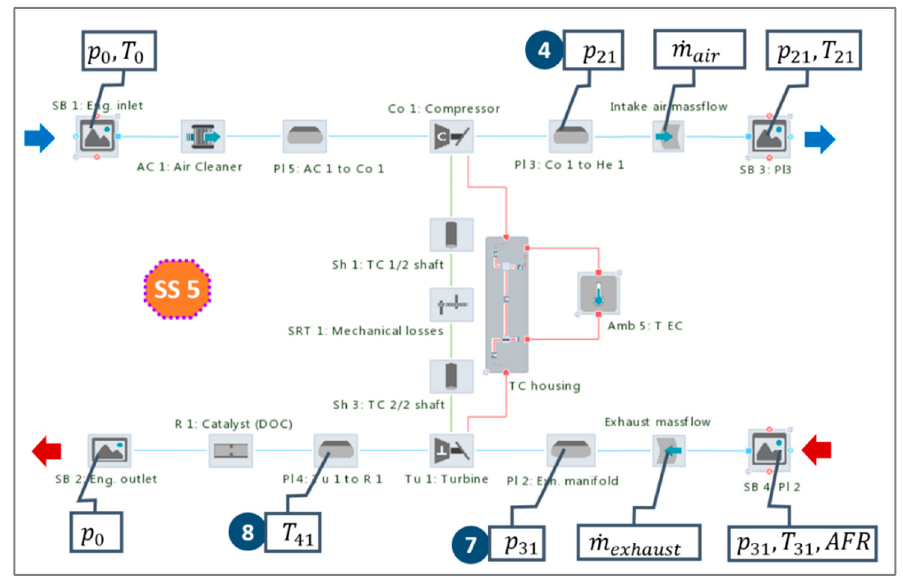
Figure 7. Layout of the simulation model of the turbocharger sub-system (SS 5) of the ICESM in Figure 2a and corresponding measurement data applied for the evaluation of the turbine HTMp and turbine efficiency correction factor in Table 1.